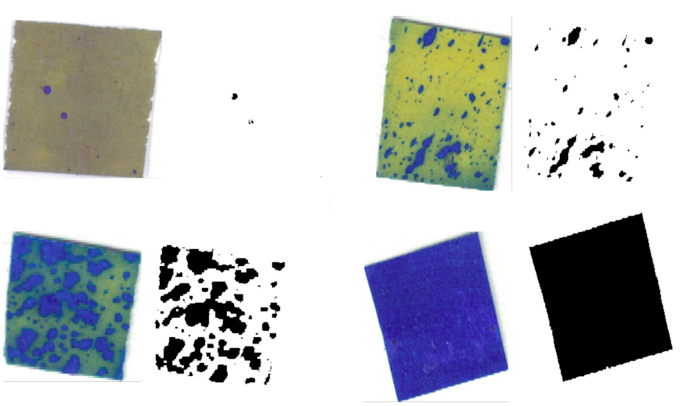
Figure 3. Some examples of single water-sensitive papers extracted by extraction algorithm (on the left in each pair) and black and white images obtained after transforming all ‘blue pixels’ to ‘black’ (on the right in each pair).